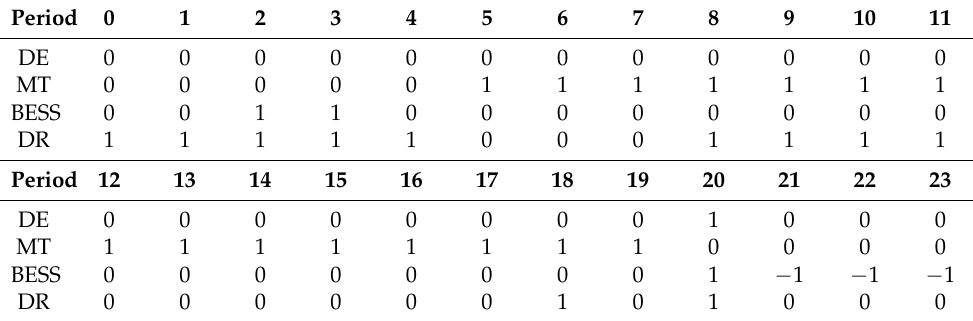
Table 9. The on–off status of the units each time period of the day using the